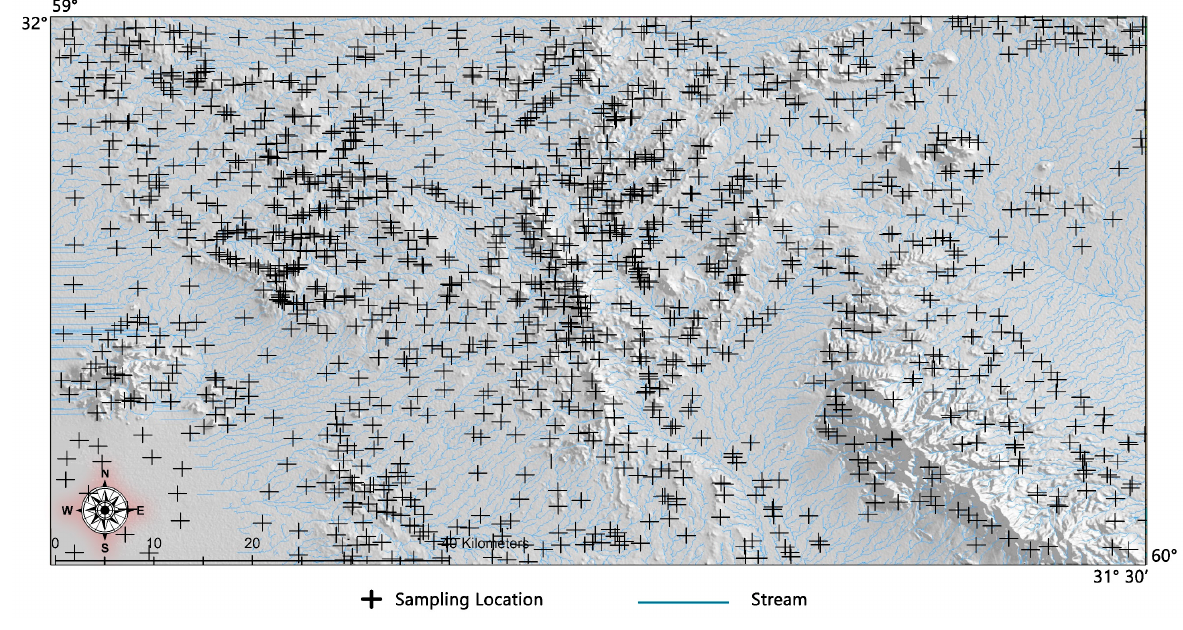
Figure 2. The geochemical sampling network in the study area.